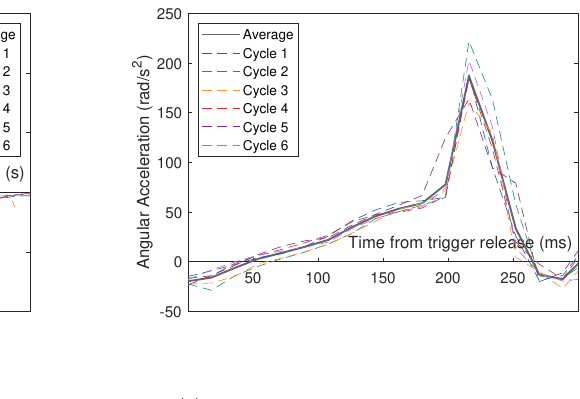
( b ) Rotational accelerations from six impact cycles. ( c ) Rotational accelerations for 0 < t < 300 ms. Figure 5. Summary of acceleration data recorded by Sabet et al. [53] during a series of controlled mild rotational impacts experienced by subject S2 to analyse brain deformation through tagged MRI. ( a ) Sequential rotational acceleration from a series of six impact cycles. The discrete bars (turquoise) indicate the time of each trigger release (approximately 1.8 s apart). ( b ) The same six acceleration cycles normalised to each trigger release, showing the complete motion until the next trigger. Each repeat is shown, however the authors have calculated and added the mean trend across the complete set (mean peak, 187 rad/s 2 ). ( c ) Rotational accelerations across the six impact repeats encompassing the impulse and subsequent brain response analysis period.